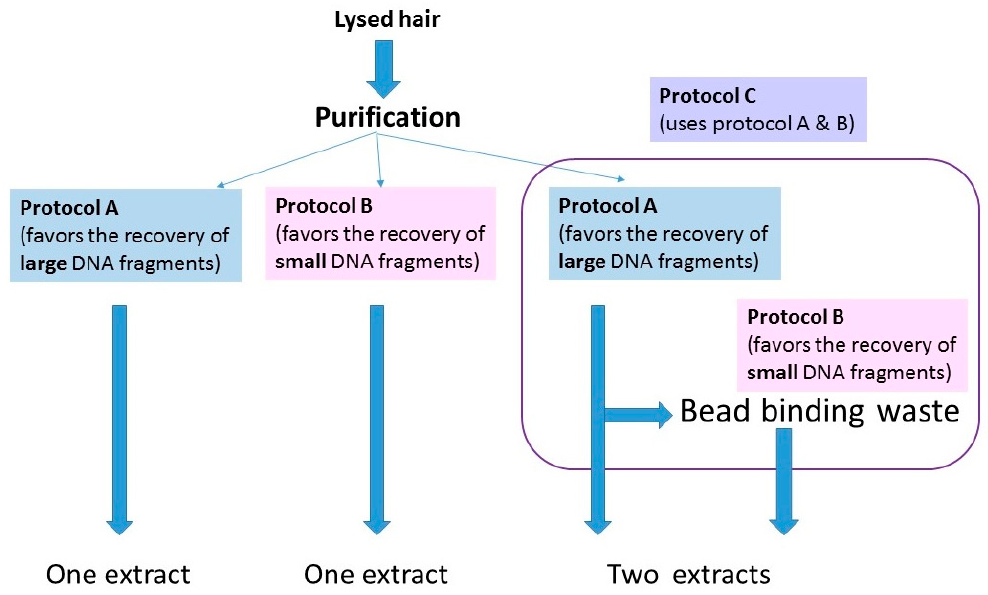
Figure 2. Schematic representation of the three purification methods used in this study. For details on the protocols, see Protocols, in the Supplementary